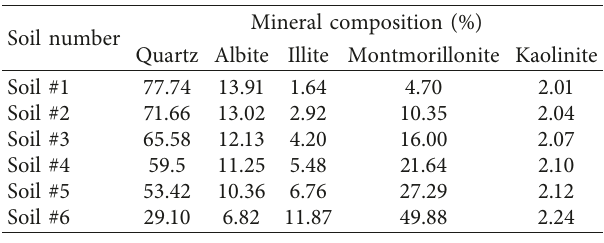
Table 2: Soil mineral